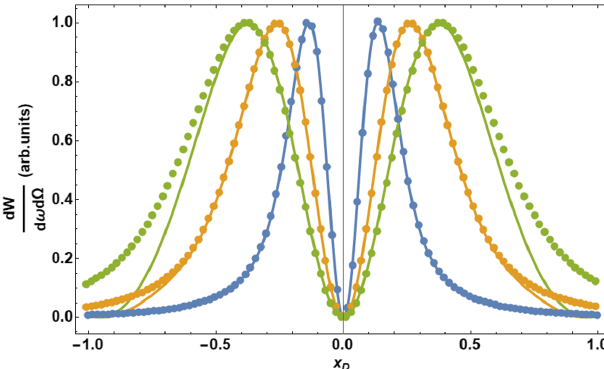
FIG. 10. Comparison of calculated COTR intensity distribu- tions in the detector plane, using field approximations Eq. (11) (solid) and Eq. (14) (dashed) for different (dimensionless) beam sizes σ x ¼ 0 . 1 (blue curve), 0.2 (orange) and 0.3 (green) and a lens aperture of x m ¼ y m ¼ 50 .